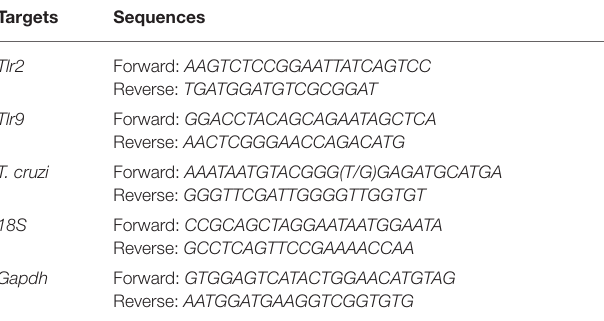
TABLE 2 | Sequences of the primers used.